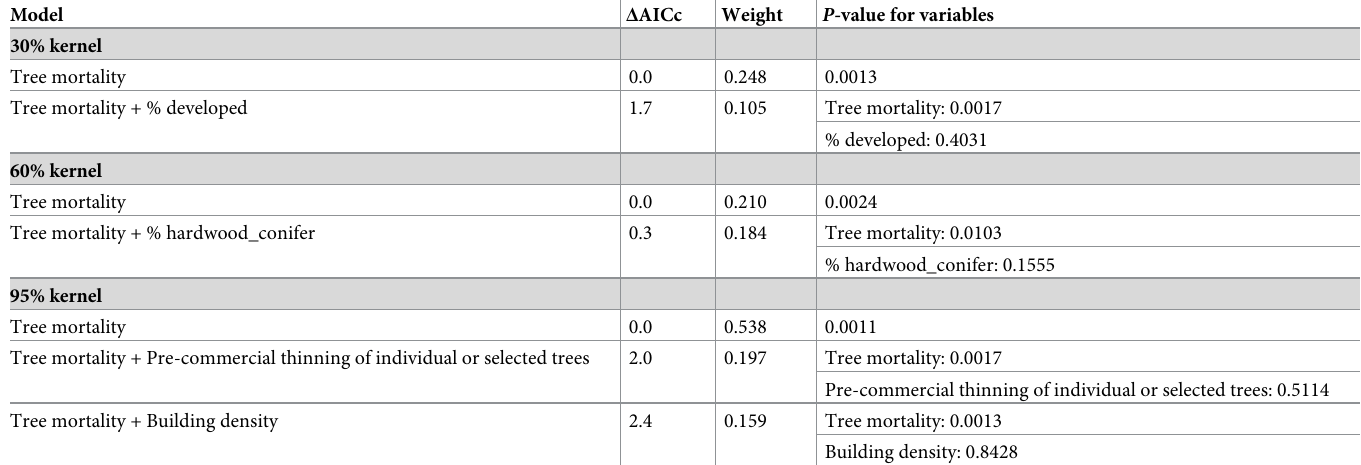
Table 2. Models with weight � 0.1 examining metrics of anthropogenic modifications, habitat, and tree mortality in the 30, 60, and 95% kernel home range of indi- vidual female fishers and the influence on hair cortisol levels, Sierra Nevada Mountains, California, 2014–2016.